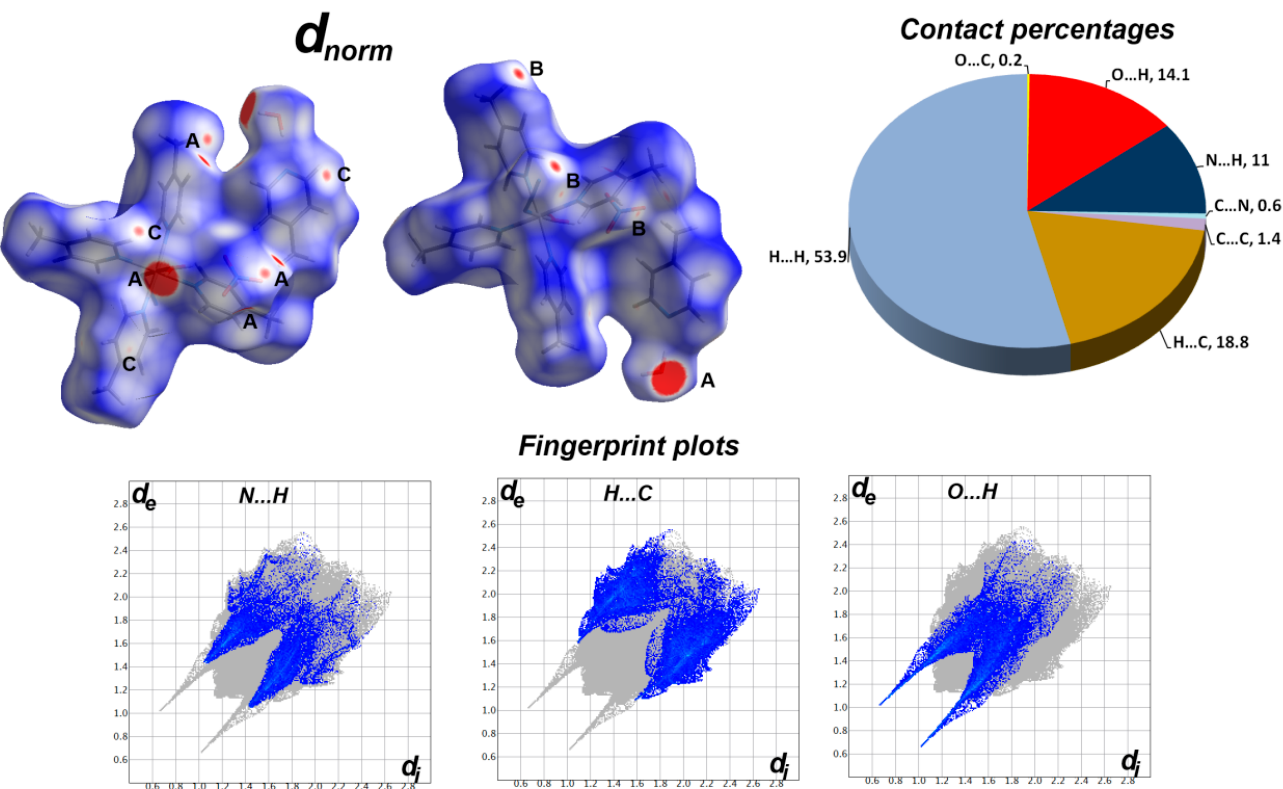
Figure 8. Hirshfeld surfaces and pie chart showing the intermolecular interactions in 1 . A–C in the d norm map belong to the O . . . H, N . . . H and H . . . C contacts, respectively. Table 6. Short distance contacts in compounds 1 and 2